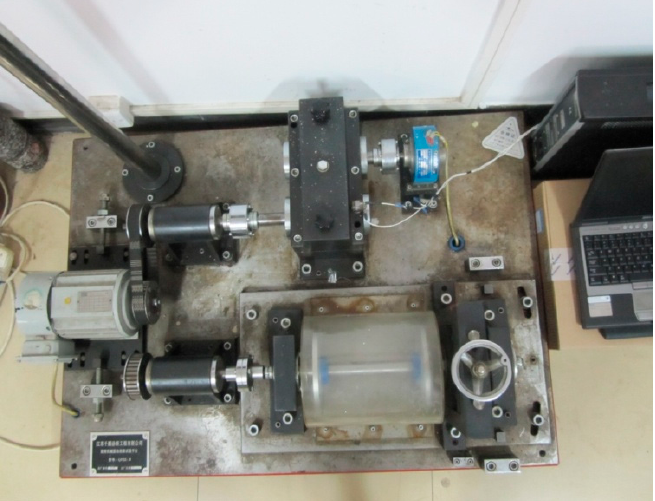
Figure 10. Top view of rotating machinery failure test bench.